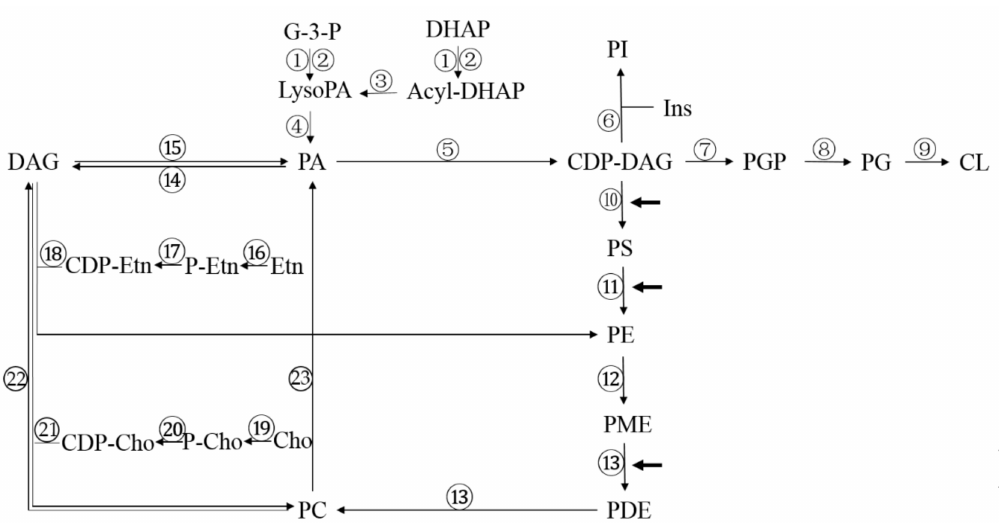
Figure 3. Metabolic network of phospholipids in S. cerevisiae. G-3-P, Glycerol-3-phosphate; DHAP, Dihydroxyacetone phosphate; PA, Phosphatidic acid; Lyso-PA, Lyso- Phosphatidic acid; Acyl-DHAP, Acyl-Dihydroxyacetone phosphate; CDP-DAG, Cytidine diphosphate-diacylglycerol; PI, Phosphatidyl inositol; Ins, Inositol; PGP, Phosphatidylglycerol phosphate; PG, Phosphatidylglycerol; CL, Cardiolipin; PS, Phosphatidylserine; PE, Phosphatidylethanolamine; PME, Phosphatidyl monomethylaminoethanol; PDE, Phosphatidyl dimethylaminoethanol; PC, Phosphatidylcholine; DAG, Diacylglycerol; Etn, Ethanolamine; P-Etn, Phospho-ethanolamine; CDP-Etn, Cytidine diphosphate-ethanolamine; Cho, Choline; P-Cho, Phospho-choline; CDP-Cho, Cytidine diphosphate-choline. PS synthase ( 10 (cid:13) ), PS decarboxylase ( 11 (cid:13) ), and phospholipid methylase ( 13 (cid:13) ), shown with